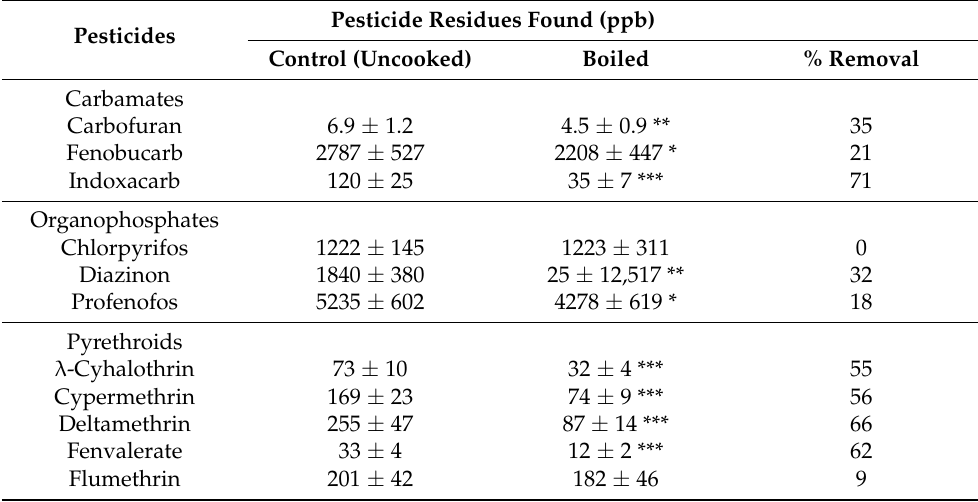
Table 1. Effects of boiling on the removal of pesticide residues from the Chinese kale